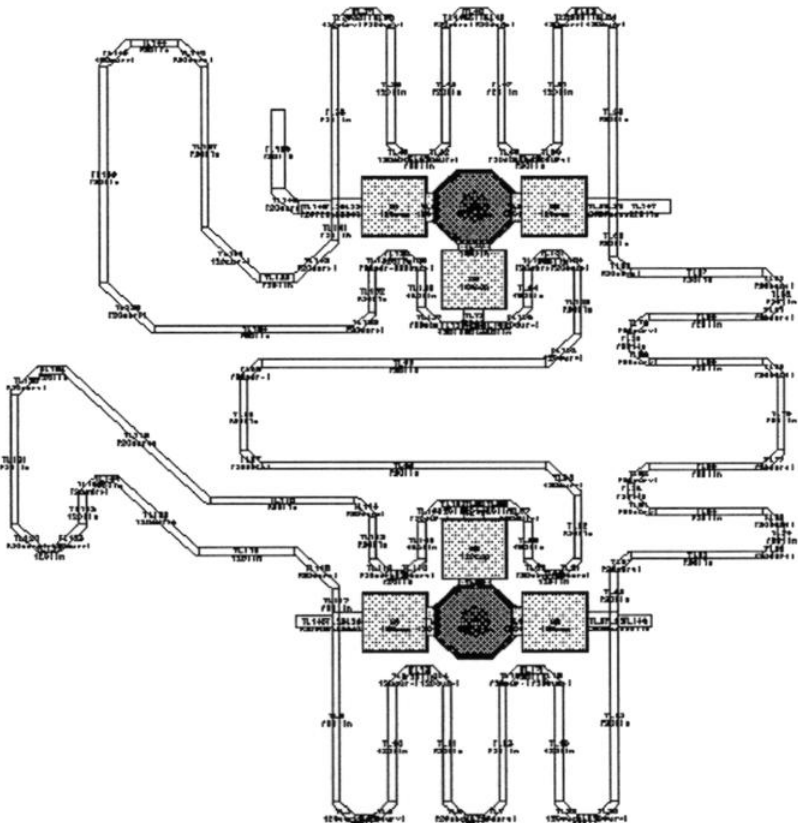
FIGURE 14 Final layout of the 180-deg coupler.